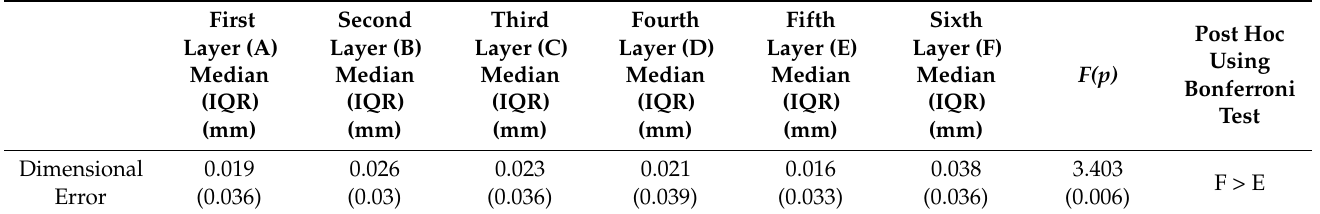
Table 1. Dimensional error (median, trueness) of the spheres’ diameter of the stacked models. Precision expressed as interquartile error (IQR). Measurements in